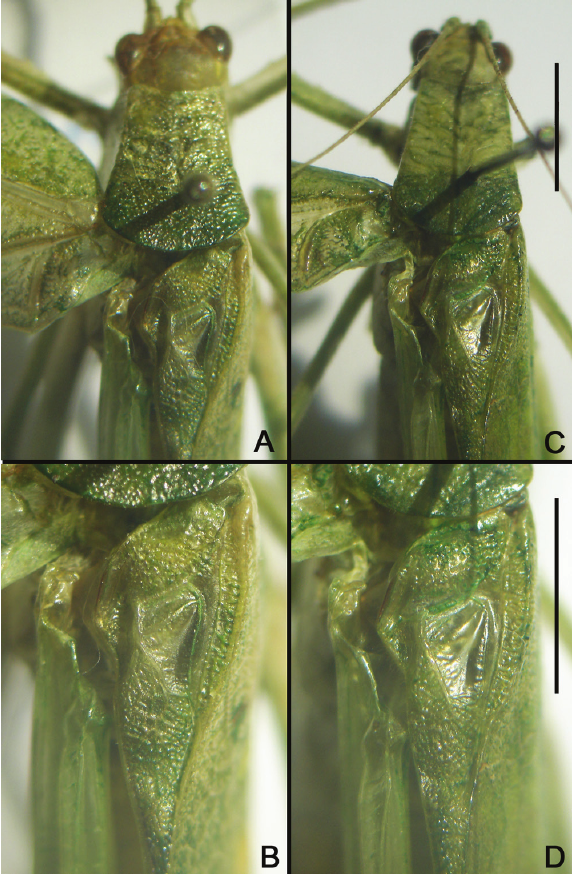
Figure 5. Pronotum and mirror area of male G. maculata ( A, B ) and male G. helleri sp. n. ( C, D ). Differences are small, the mir- ror of G. helleri sp. n. being more shiny and translucent. Scale bars 5